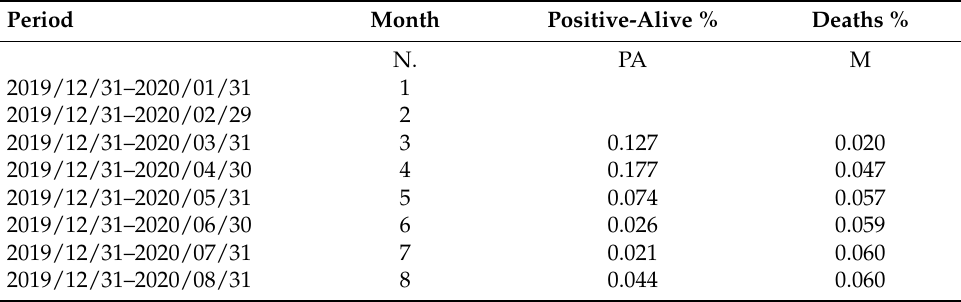
Table 1. Percentages of Positive-alive and Deaths due to COVID-19 in Italy. Period Month Positive-Alive % Deaths % N. PA